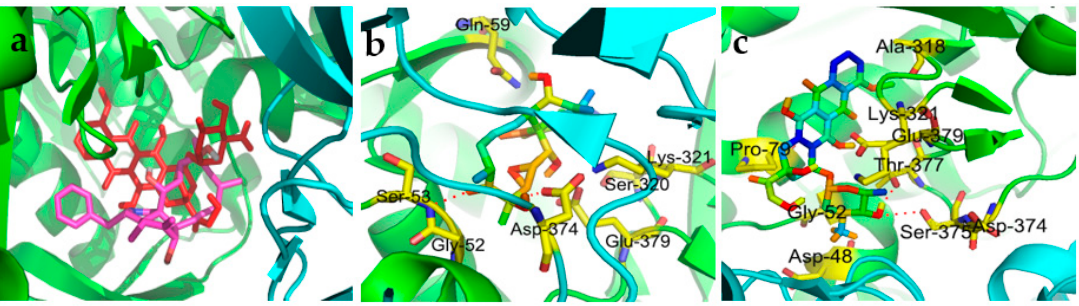
Figure 2. Molecular docking simulations of the overlay view of engleromycin (magenta) with doxorubicin (red) in the Top II (PDB: 1ZXM) binding pocket ( a ), and their ligand–protein interactions between engleromycin ( b ) and doxorubicin ( c ) with Top II, respectively.